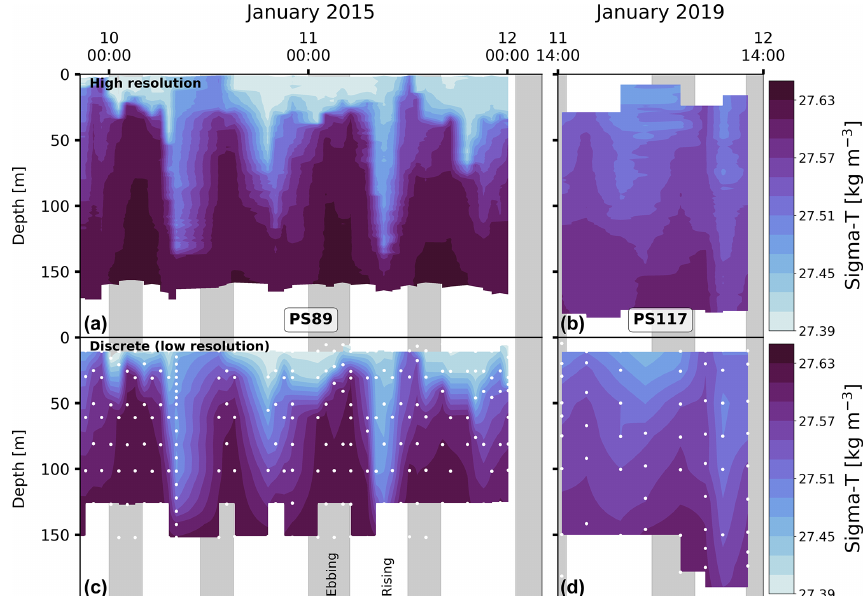
Figure E1. (a) High vertical resolution profile of sigma- t for PS89. (b) High vertical resolution profile of sigma- t for PS117. (c) Discrete (low vertical resolution) profile measurements at bottle sampling depth for PS89. (d) Discrete (low vertical resolution) profile measurements at bottle sampling depth for PS117. Sampling depths are shown in white markers in (c) and (d) .